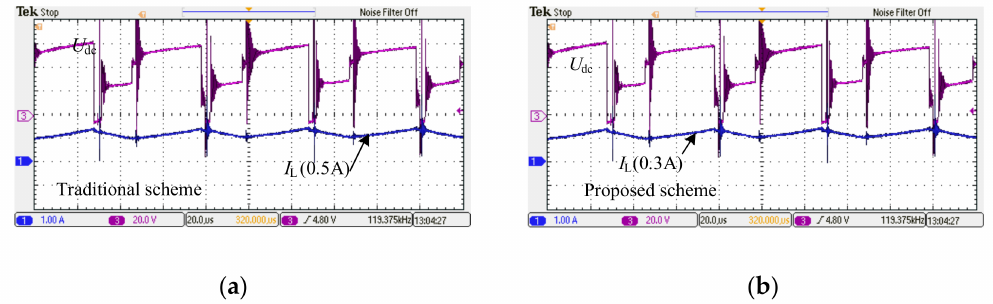
Figure 17. Comparison waveforms of conventional and proposed schemes. ( a ) Traditional scheme ( b ) Proposed